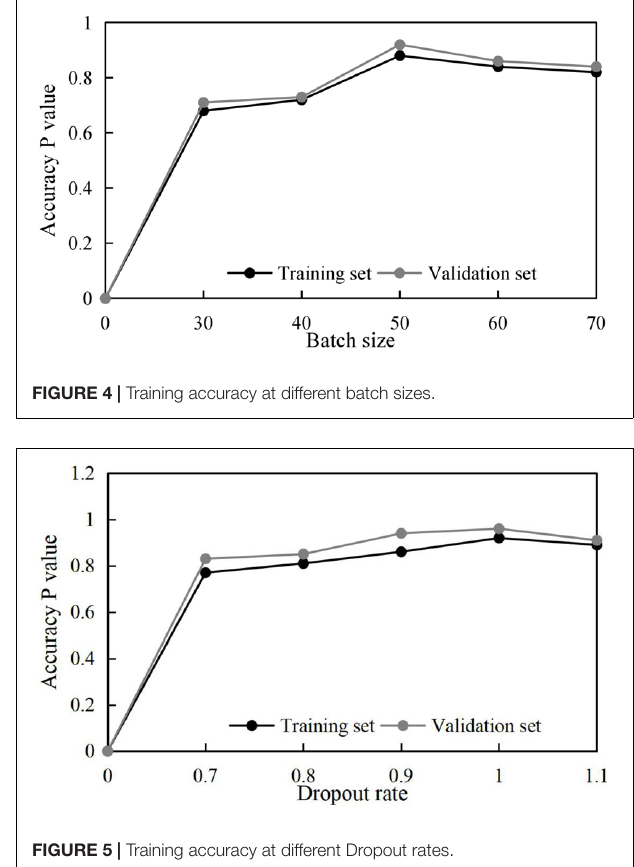
FIGURE 5 | Training accuracy at different Dropout rates.